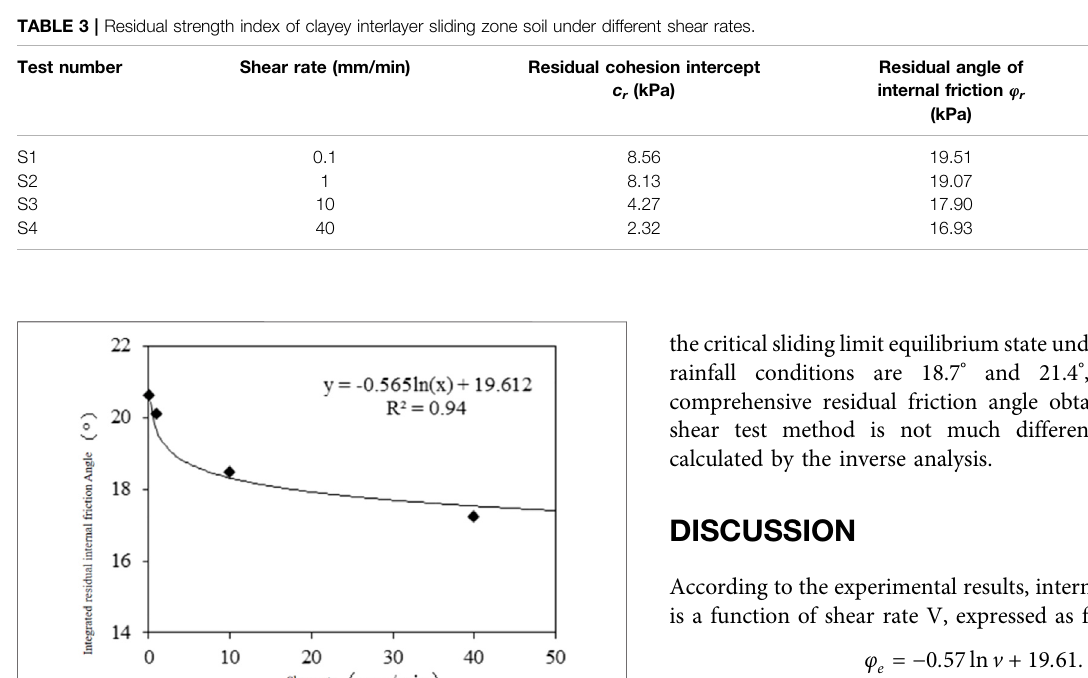
Frontiers in Earth Science |